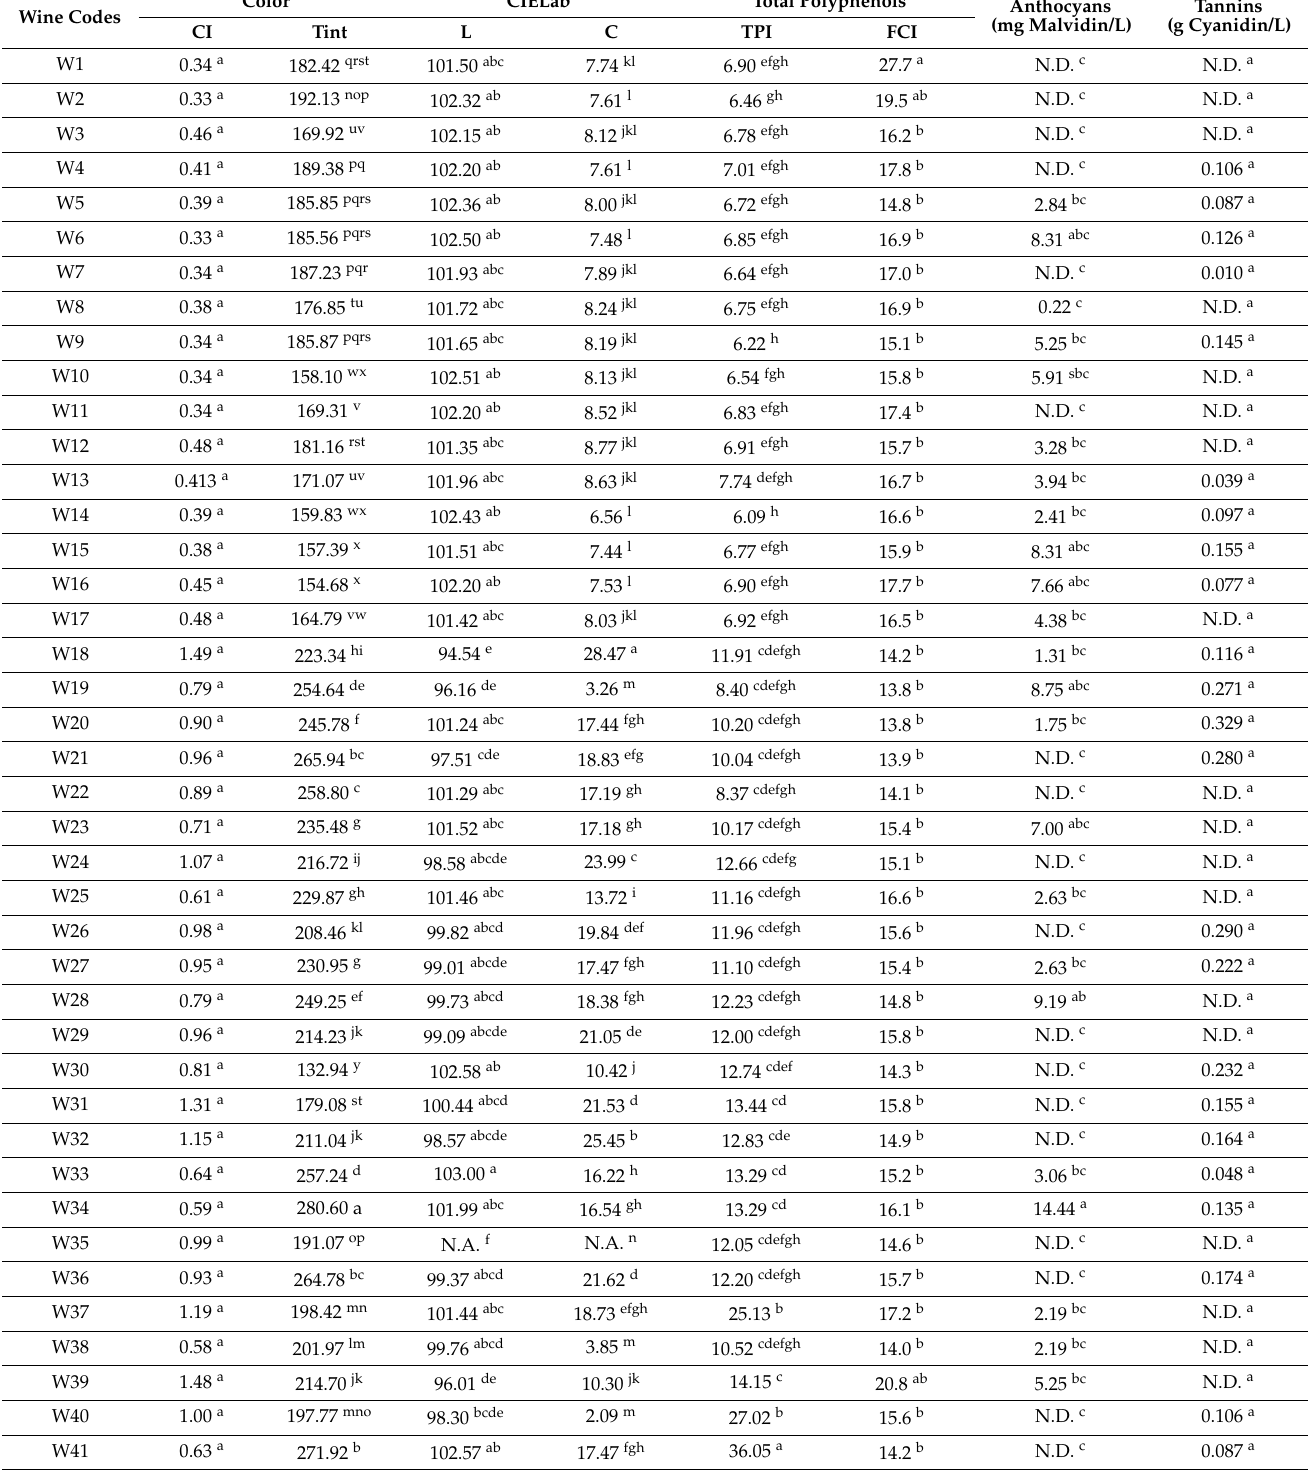
Table 3. Color and phenolic properties of studied white